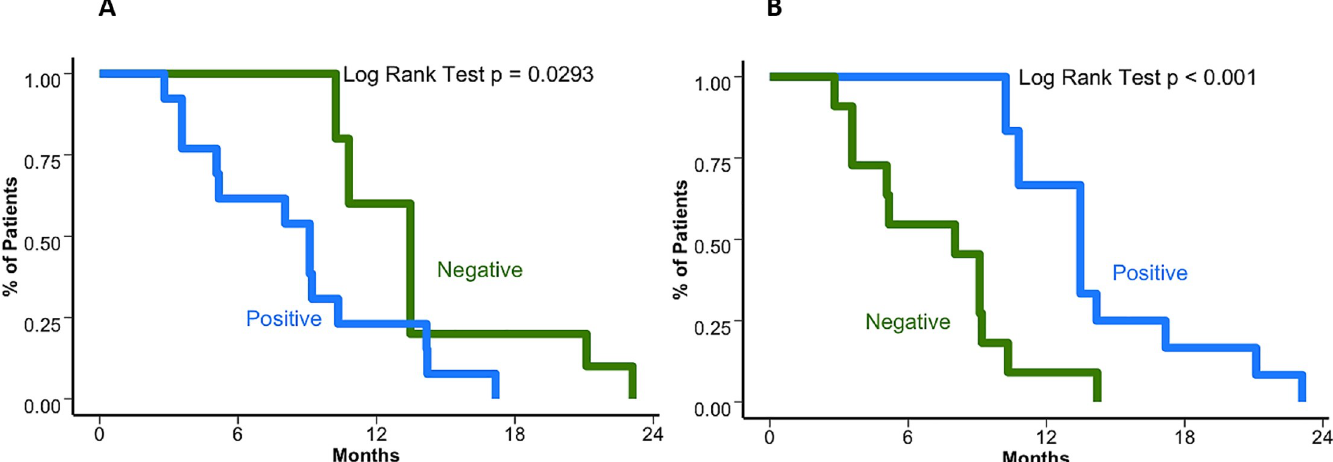
Fig 4. Survival outcomes based on VEGFR2 and PDGFR β expression. (A). Kaplan–Meier curve for progression free survival (PFS) based on VEGFR2 expression. The median PFS when VEGFR2 expression is positive was 9.1 months (95%CI 5.07–13.4) vs .13.5 months when protein expression was negative (95%CI 10.8–17.2) ( p = 0.029). (B) Kaplan–Meier curve for progression free survival (PFS) based on PDGFR β expression. The median PFS when there is positive reactivity was 13.5 months (95%CI 10.8–15.4) vs 8.0 (95%CI 5.07–10.2) ( p < 0.001) for those who were negative.